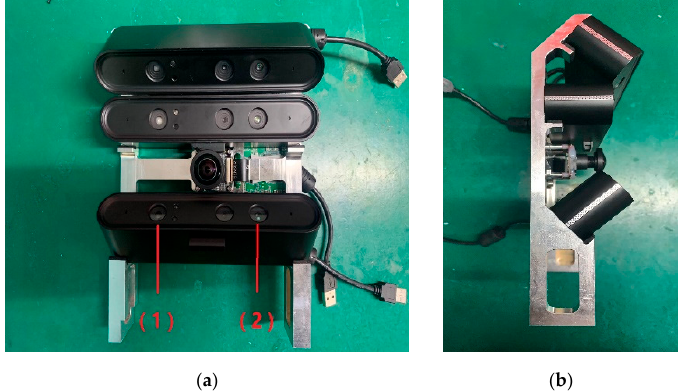
Figure 4. Placement of the multiple depth cameras. ( a ) and ( b ) are the front and side views, respectively. (1) is the infrared projector; (2) is the infrared camera.